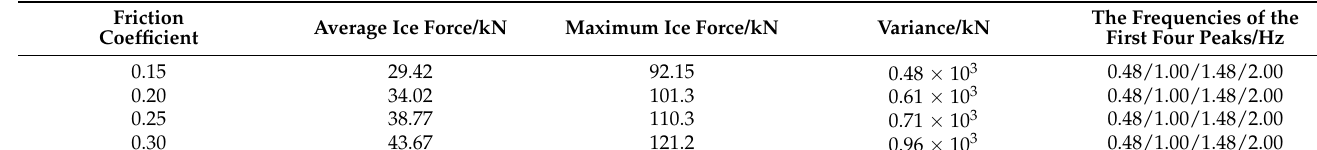
Table 10. Statistics of ice force under different friction coefficients ( µ ).